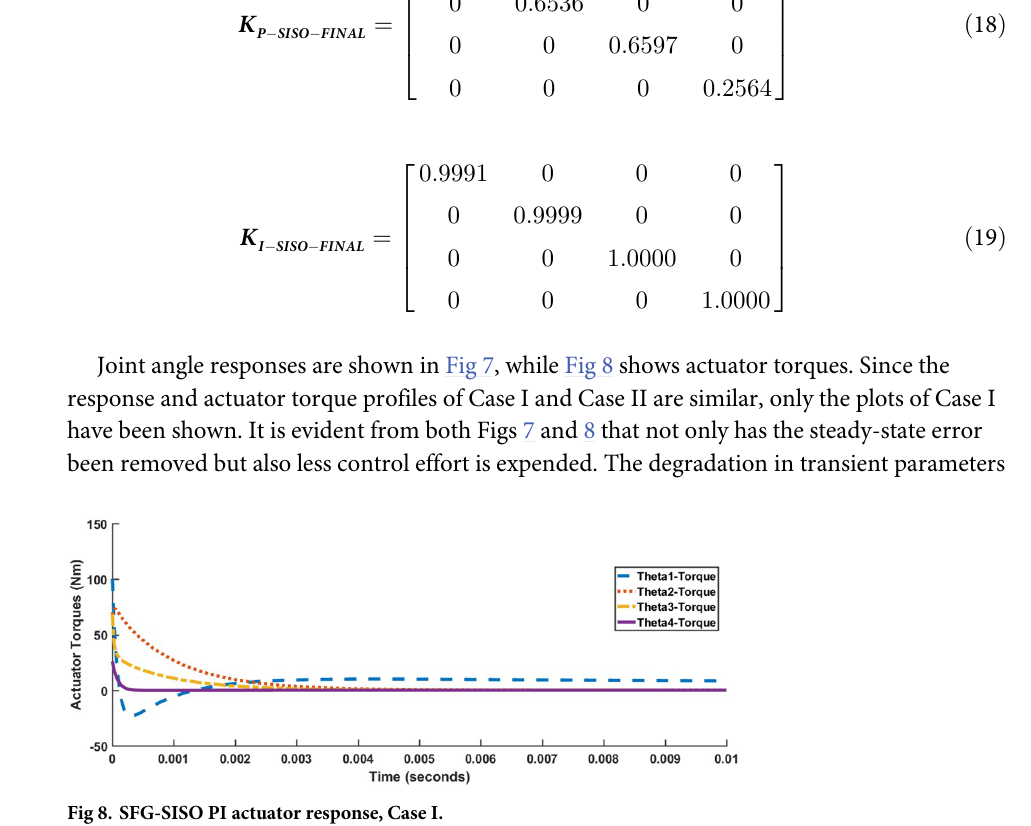
Fig 8. SFG-SISO PI actuator response, Case